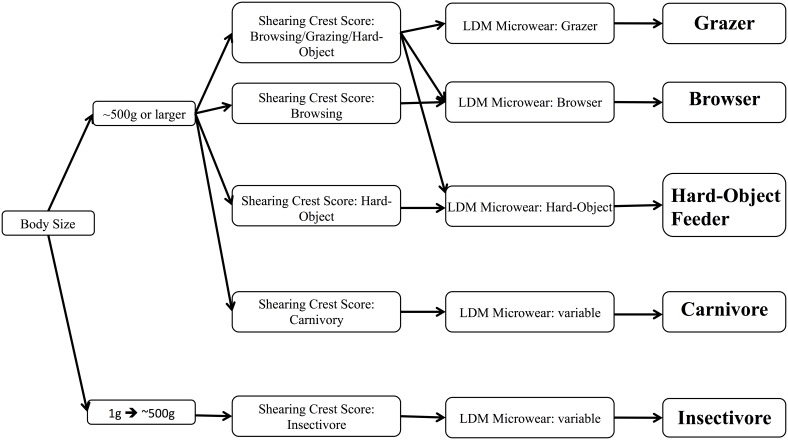
Flow chart representing the path taken toward the assignment of feeding guild using the three different analyses (body size, tooth morphology, LDM microwear) in succession.